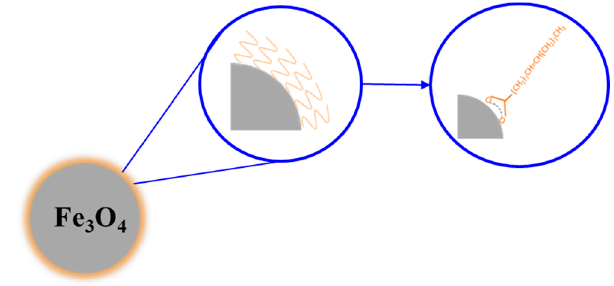
Figure 7. Magnetite NP functionalized with oleic acid.